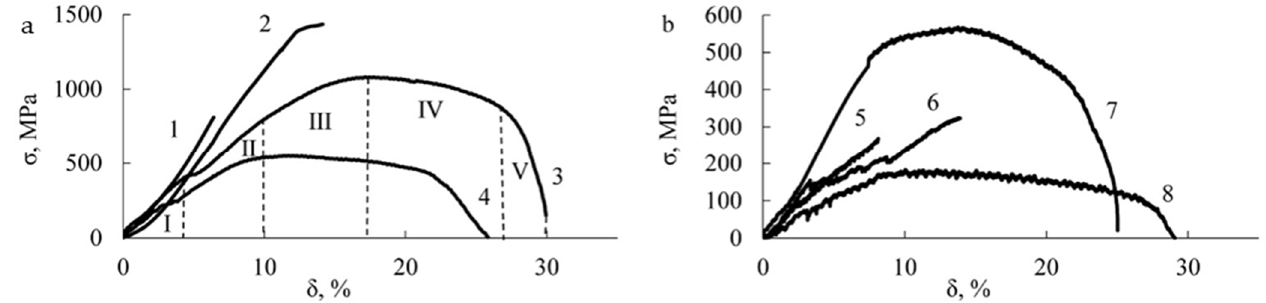
Figure 33. «Stress–strain» (MPa) tensile curves of the Cu–14Al–3Ni alloy after HPT to 10 revolutions, at ( a ) ~ 1 × 10 –3 1/s and temperatures of (1) 300, (2) 423, (3) 573, (4) 673 K; and at ( b ) v ~ 10 –4 1/s and (5) 423, (6) 473, (7) 573, and (8) 673 K. I–V are the stages of deformation [65]. Table 7. Tensile test results at elevated temperatures for the UFG Cu–14Al–3Ni alloy after HPT to 10 revolutions.